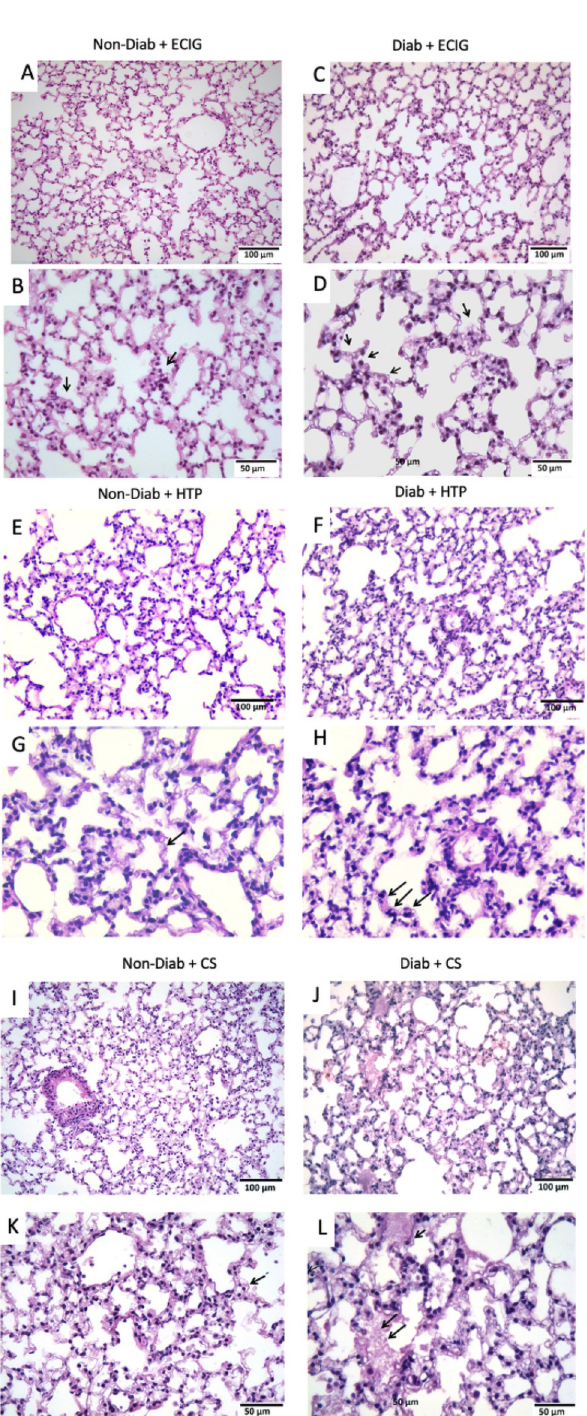
Fig 1. Histology of lungs of Non-Diabetic vs Diabetic after seven days of ECIG, HTP and CS exposure. Non- Diabetic lungs + ECIG showing limited lung injury with thin interstitial alveolar wall and fine capillary vessels (Fig 1A; magnification x 20). Rare inflammatory cells in the wall and intra-alveolar spaces are noted (Fig 1B; magnification x 40). Sections from Diabetic + ECIG lungs demonstrate limited areas of thickening of the interstitial wall, capillary congestion and limited areas of inflammation (Fig 1C; magnification x 20). Arrows point to a significant presence of inflammatory cells (Fig 1D; magnification x 40). Non-Diabetic lungs + HTP showing patches of alveolar wall edema and capillary congestion (Fig 1E; magnification x 20). Those findings were significantly worse in Diabetic lungs